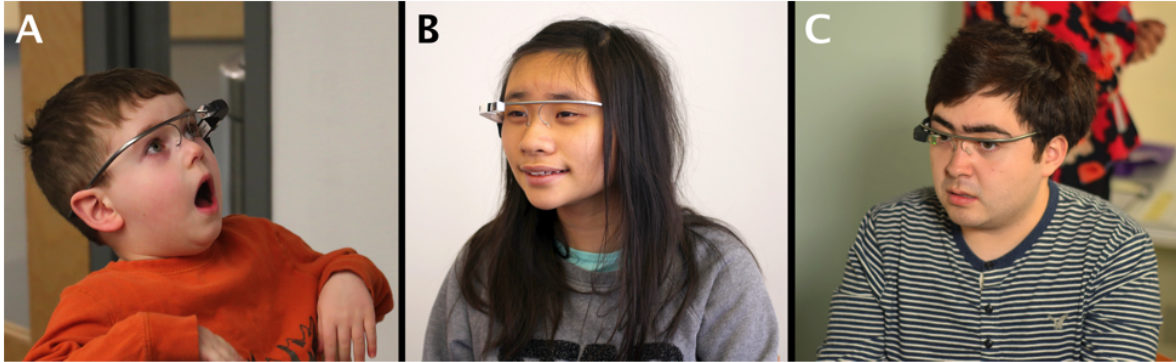
Figure 1. Three users with autism wearing the Brain Power Autism System and using its socioemotional coaching apps. Pictures used with user/caregiver